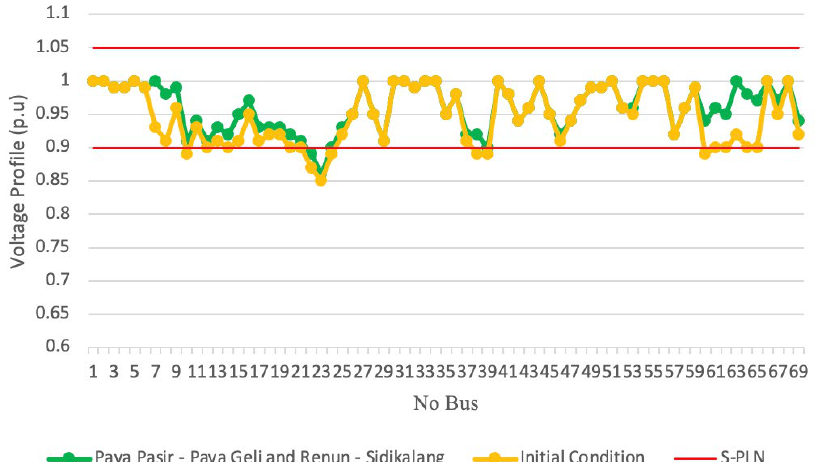
Figure 10. Voltage profile of the SUMBAGUT 150 kV transmission system after changing the Paya Pasir (Bus 5)–Paya Geli (Bus 7) and Paya Pasir (Bus 5)–Sei Rotan (Bus 11) lines to the HVDC transmission system.